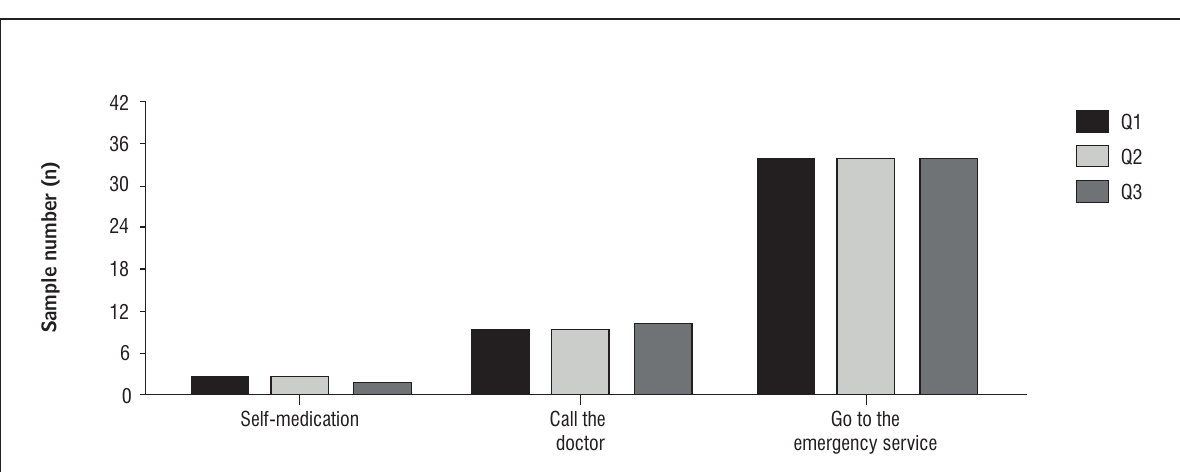
Figure 4 - What is the first step to take when you identify the worsening of the disease? Note: Correct answer: Self-medication or call the doctor or go to the emergency service. Q1 = Questionnaire applied before of the